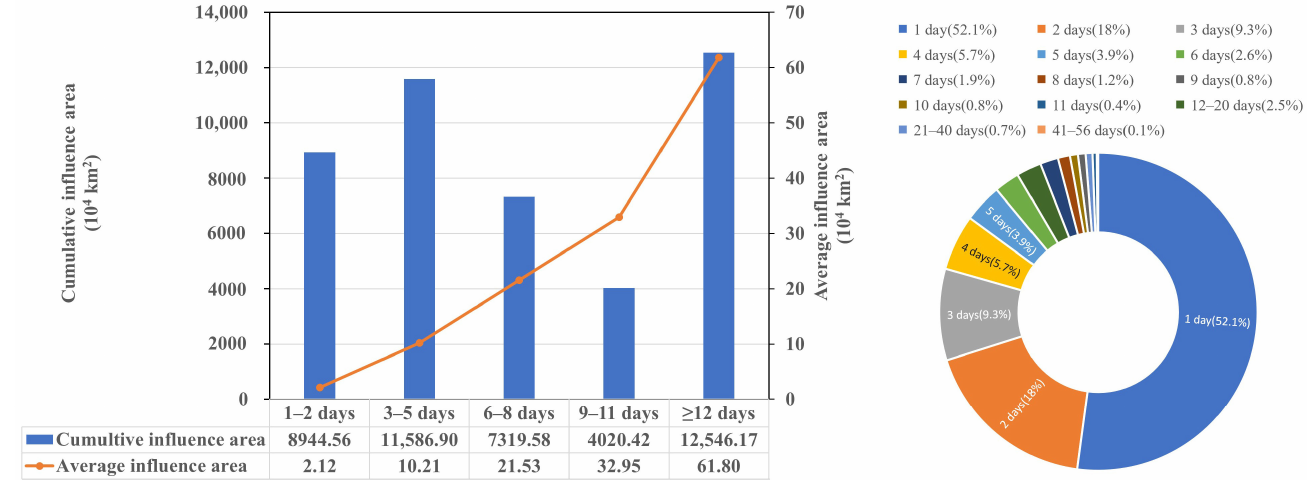
Figure 11. The cumulative and average influence areas of heatwave events of different durations across China from 1979 to 2018. The pie chart on the right illustrates much more details about the percentage of the number of heatwave events of an individual duration to that of all durations.